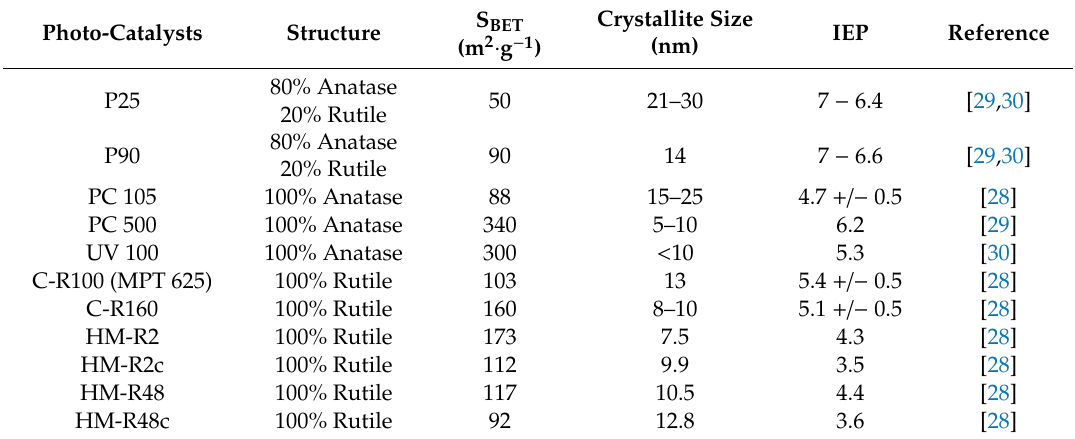
Table 1. Structure, surface area, Iso Electric Point (IEP) and crystallite size of each photocatalyst.